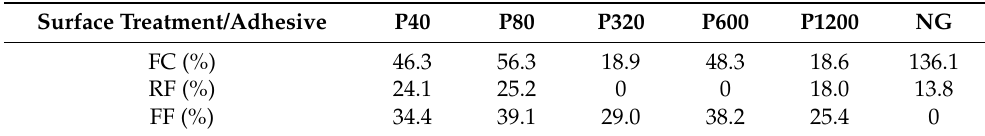
Table 5. Improvement percentage ( IP ) data of shear joints resistance after the application of adhesion promoter ( SR P ) with respect to the values obtained without promoter ( SR NP ).